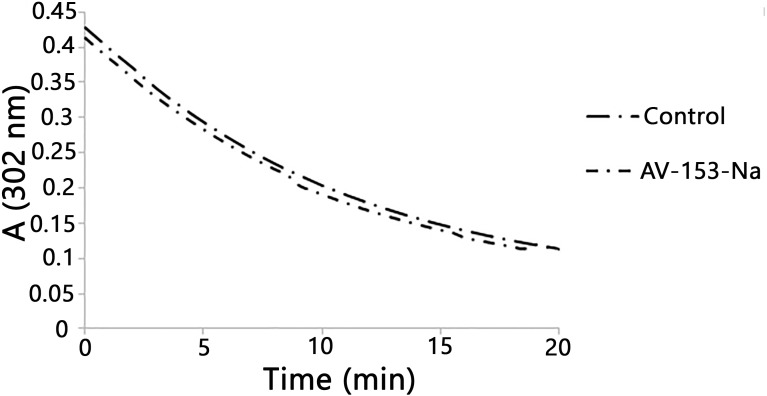
Reaction with peroxynitrite assay.Curves demonstrate decomposion of peroxynitrite (0.38 mM) in the presence of AV-153-Na added up to 0.16 mM at pH 10. The 1,4-DHP was added also to the control cuvette.